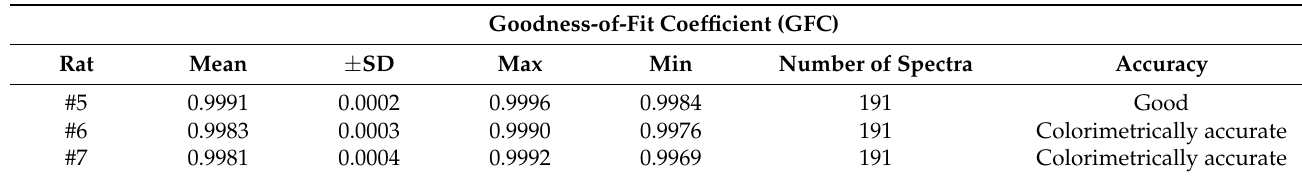
Table 2. Goodness-of-fit coefficient (GFC) obtained from three rats during changes in FiO 2 .